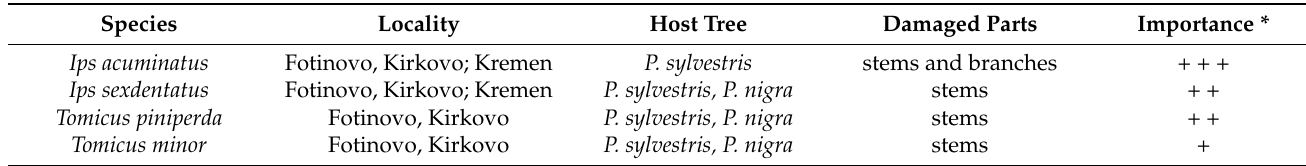
Table 4. Bark beetles found in studied pine